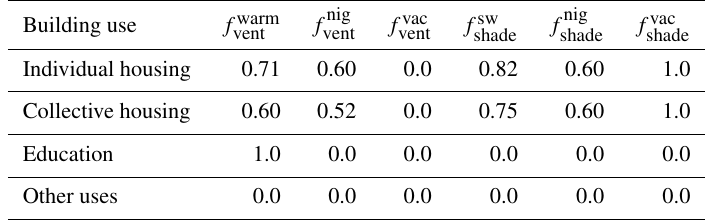
Table A5. Fraction of buildings for which ventilation ( f vent ) or shading ( f shade ) is applied during warm conditions (warm) or as a function of the shortwave radiation (sw), the night (nig) and when the building is vacant (vac). For the residential buildings, the values are based on the ENERGIHAB survey.